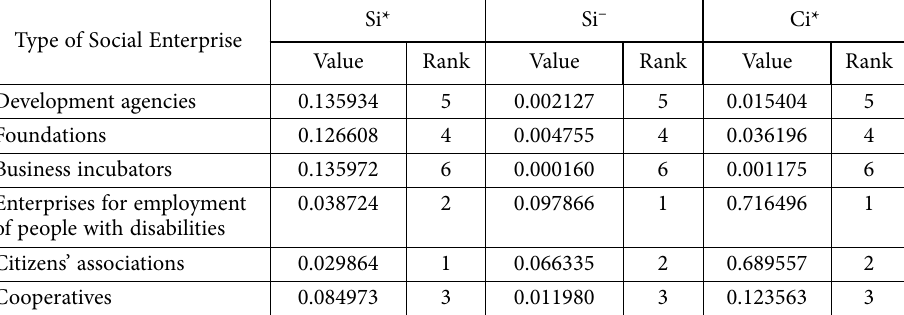
Table 5. Results of TOPSIS (source: authors’ calculation) Si* Si – Ci* Type of Social Enterprise Value Rank Value Rank Value Rank Development agencies 0.135934 5 0.002127 Foundations 0.126608 4 Enterprises for employment of people with disabilities